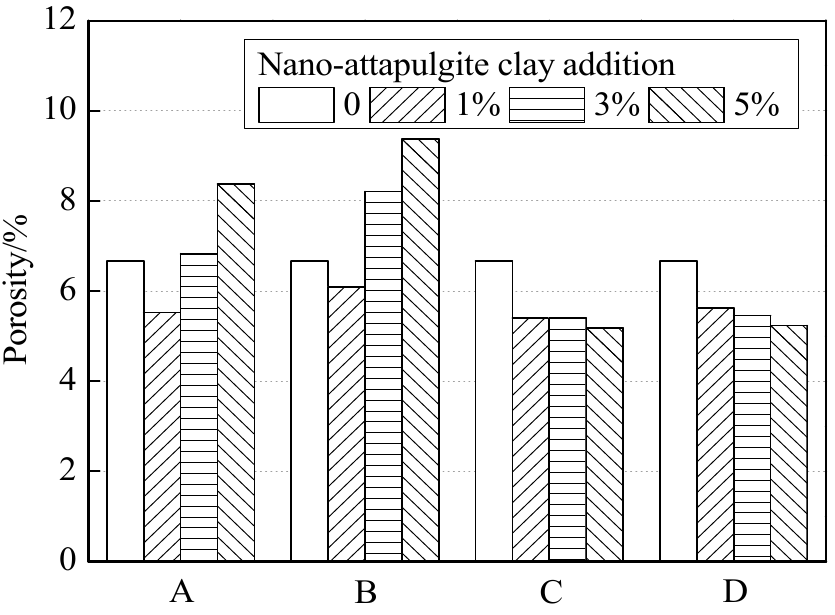
Figure 16. Stomatal content of cement paste with various NAC addition. From Figure 15, it can be observed that the visible pores of the cement paste mixed with calcined NAC were notably fewer than those of the cement paste mixed with uncalcined NAC and those of the cement paste without NAC. There was a notable number of visible pores in the fracture section of the cement paste mixed with uncalcined NAC raw ore, and the number and the diameter of the pores grew as the mixing amount increased; when the mixing amount reached 5%, visible pores with a diameter of approximately 4 mm appeared. A large number of visible pores emerged in the fracture section of the cement paste mixed with uncalcined NAC high-viscosity ore at a mixing amount of 3%, and the pore diameter stood at around 1 mm. The mixing amount reached 5%, and there were massive irregular pores in the fracture section of the cement paste. The content of visible pores in the fracture section of the cement paste that prominently improved by adding the calcined NAC was remarkably reduced, with only a few pores observable by the naked eye. We can draw that the calcined NAC has the potential to enhance the compactness of the cement paste. From Figure 16, it can be drawn that adding 3% and 5% uncalculated NAC can reduce the compactness of hardened cement paste and increase the porosity. The porosity of cement mixed with 3% and 5% uncalculated NAC raw ore is 2.44% and 25.58% higher than that of the cement without NAC. The porosity of cement mixed with 3% and 5% uncalculated NAC high-viscosity mineral is 23.07% and 40.62% higher than that of the cement without NAC. This indicated that an uncalculated high-viscosity mineral is not conducive to forming dense hardened cement. Adding calcined NAC can effectively reduce the porosity of hardened cement and improve the compactness, which is consistent with the conclusion in Figure 15. The porosity of hardened cement with 1%, 3%, and 5% NACis 19%, 19.04%, and 22.27% lower than that of the cement without NAC. When the content of NAC with high viscosity is 1%, 3%, and 5%, the porosity of hardened cement paste is 15.58%, 18.1%, and 21.46% lower than that of the cement without NAC, which indicates that calcined NAC raw ore has the best effect in improving the compactness of hardened cement paste. The effect is the best when the content is